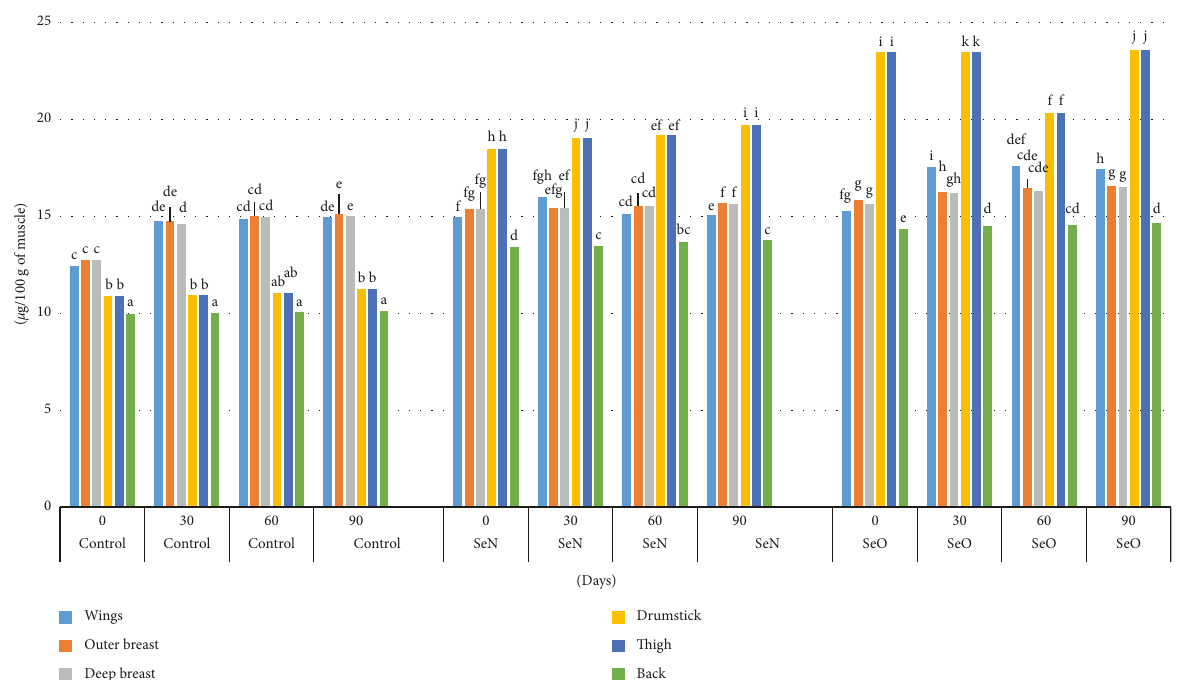
Figure 1: The content of selenium in selected culinary parts of chicken supplemented with organic and inorganic